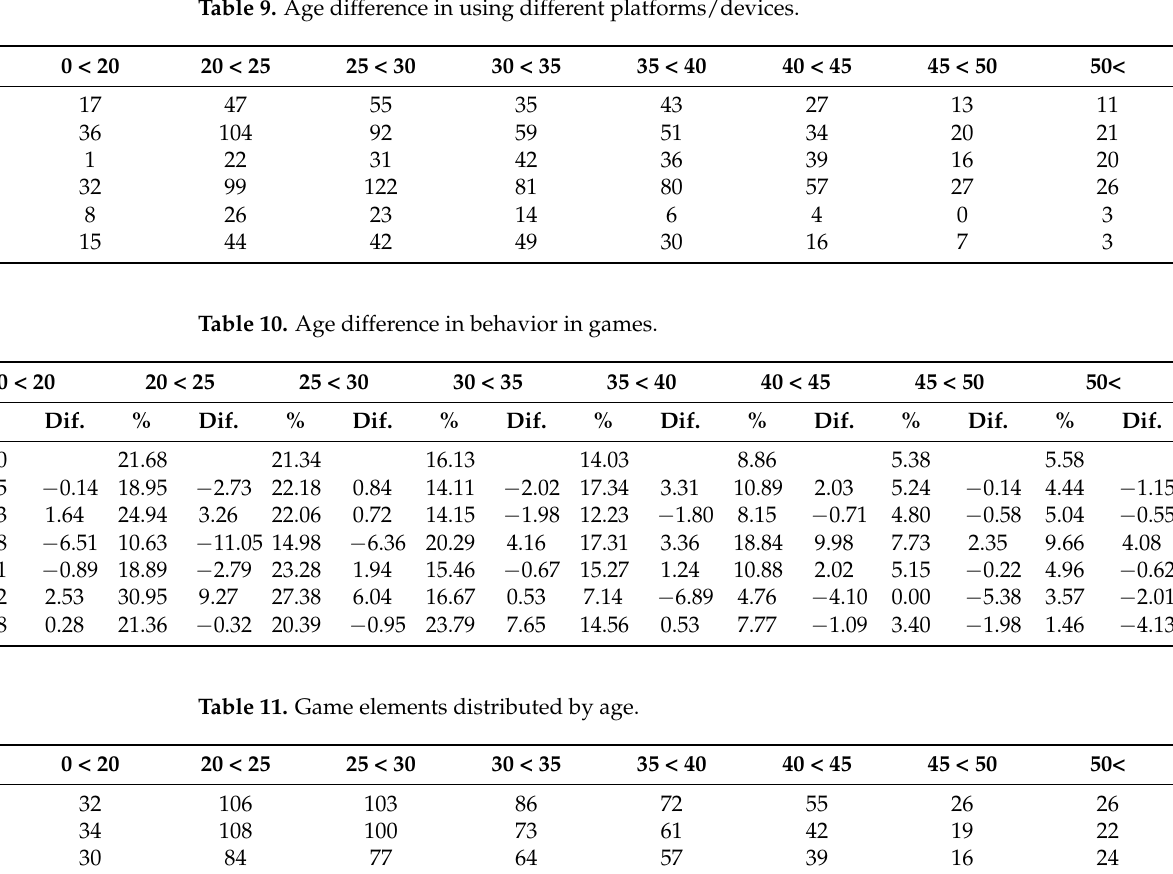
Table 9. Age difference in using different platforms/devices.